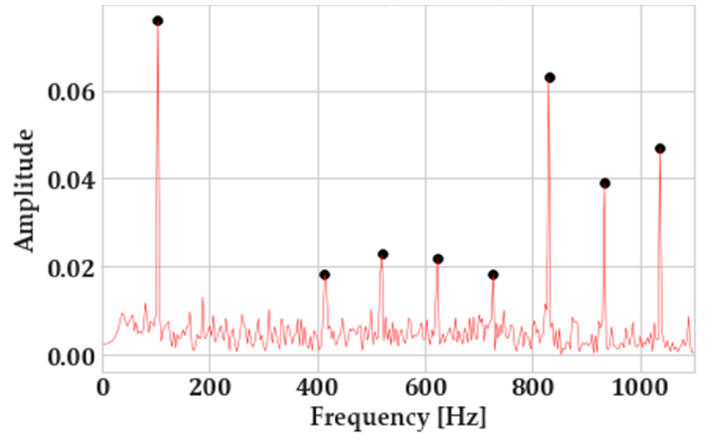
Figure 8. Mode identification from the FFT of the vibration signal.